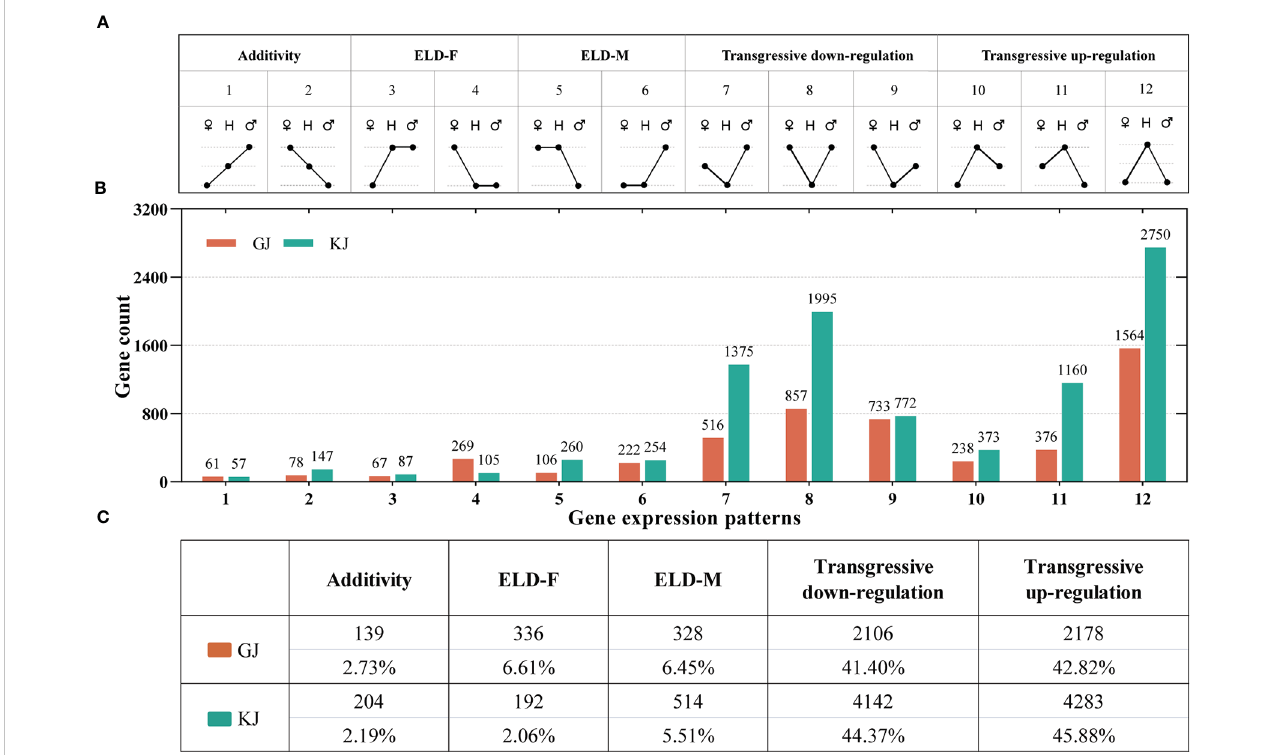
FIGURE 4 12 gene expression patterns of DEGs between hybrids and parents. (A) Classi fi cation of 12 gene expression patterns ( ♂ : paternal; H: hybrid; ♀ : maternal). (B) The number of genes of GJ and KJ hybrids in each model. (C) The number and proportion of the fi ve total expression patterns after classi fi cation in